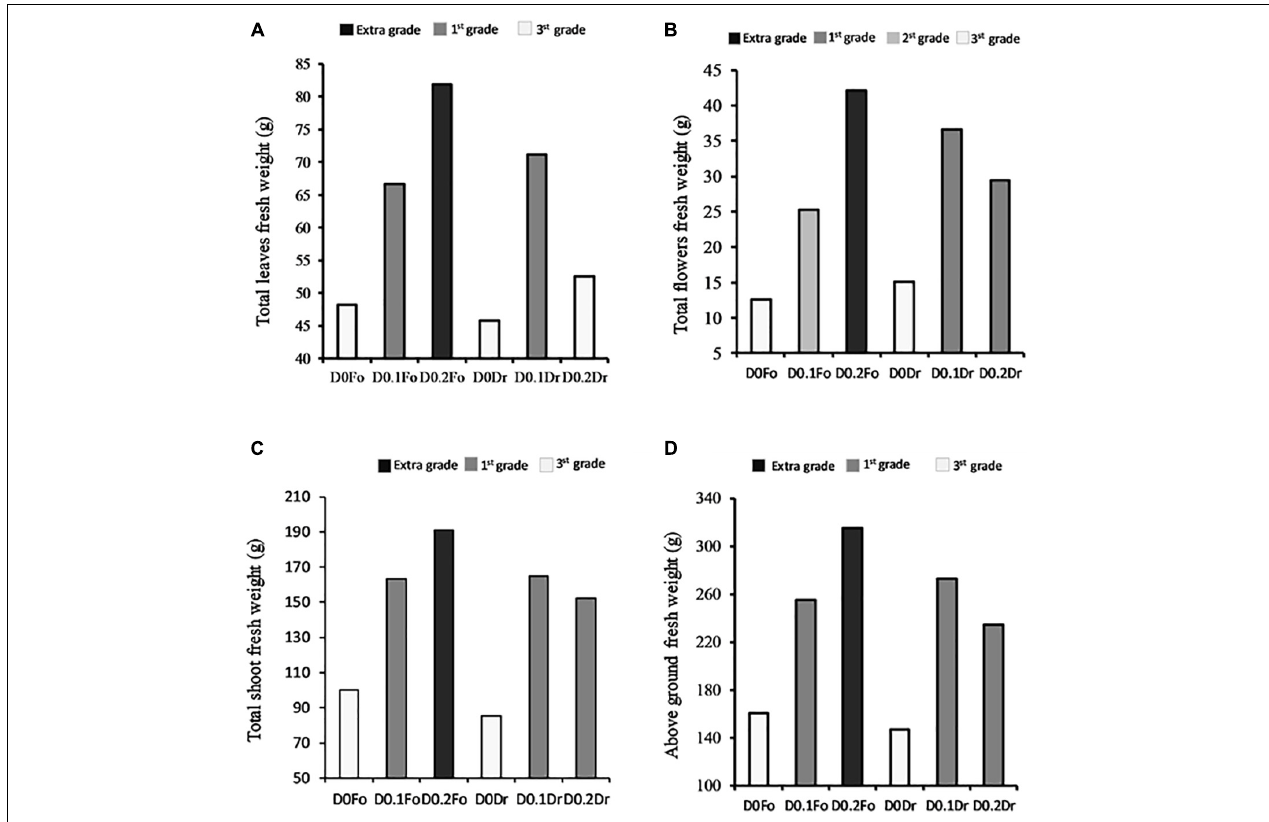
FIGURE 2 | Interaction effects of biostimulant dose (D0, D0.1, and D0.2) × application method (Fo = foliar spray and Rd = root drenching) on petunia plant grade [total fresh weight of leaves (A) , total fresh weight of flowers (B) , total fresh weight of shoots (C) , and aboveground fresh weight (D) ].